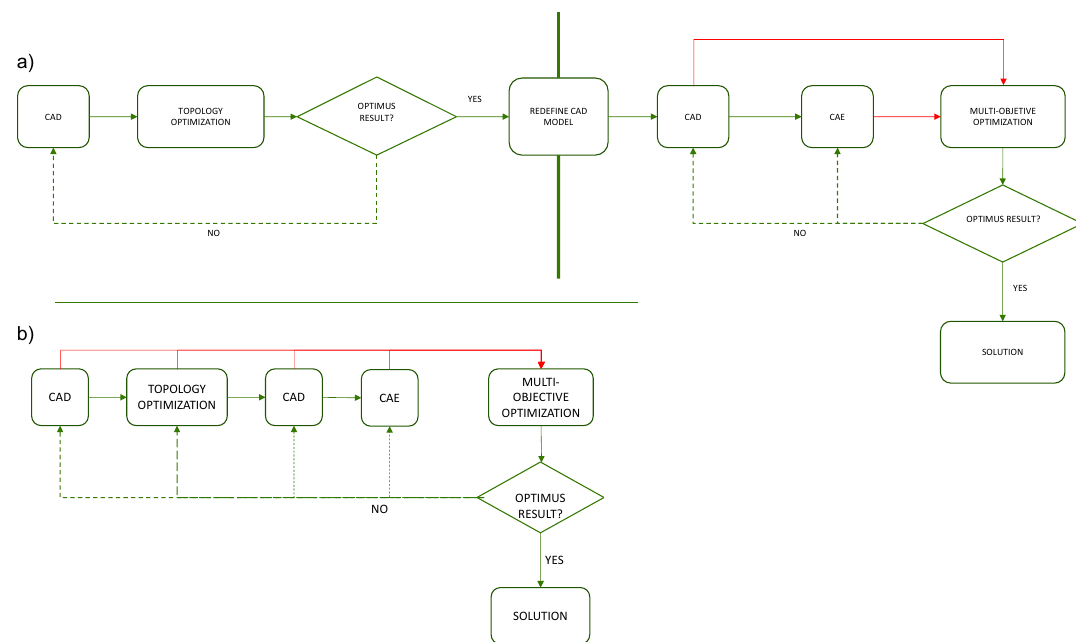
Figure 3. ( a ) Workflow in optimization methodologies of most software. ( b ) Workflow in the optimization methodology proposal in Grasshopper.